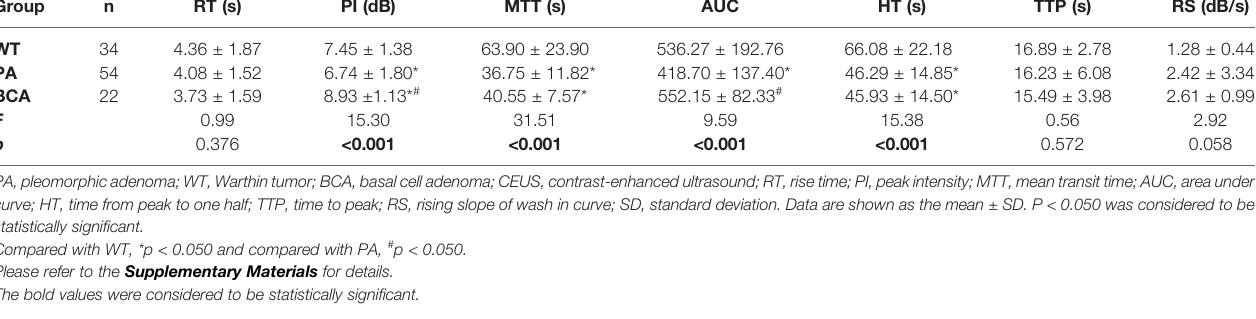
TABLE 4 | Comparison of quantitative parameters of time-intensity curves (TICs) by contrast-enhanced ultrasonography (CEUS) for common benign parotid gland tumors (Mean ± SD) (n = 110). Group n RT (s) PI (dB) MTT (s)